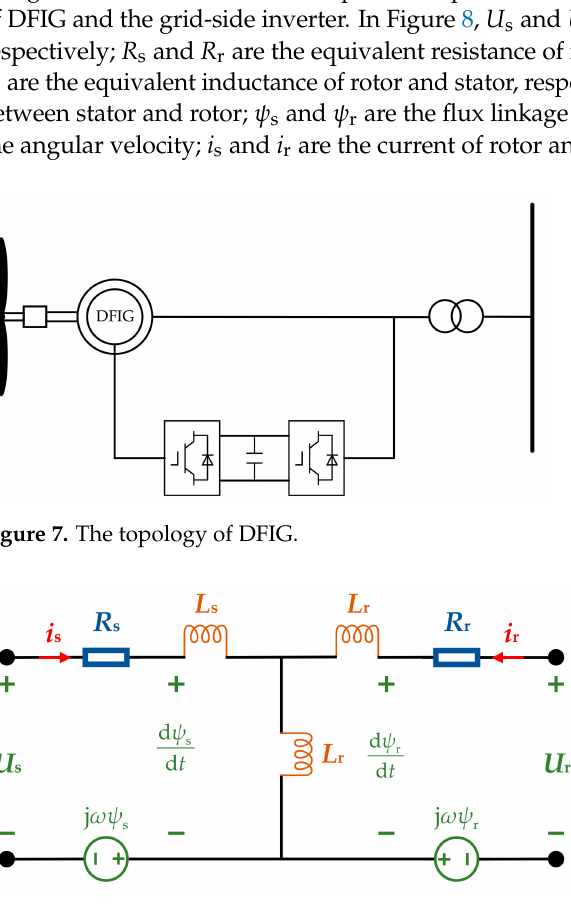
Figure 8. The equivalent circuit of doubly-fed induction generators